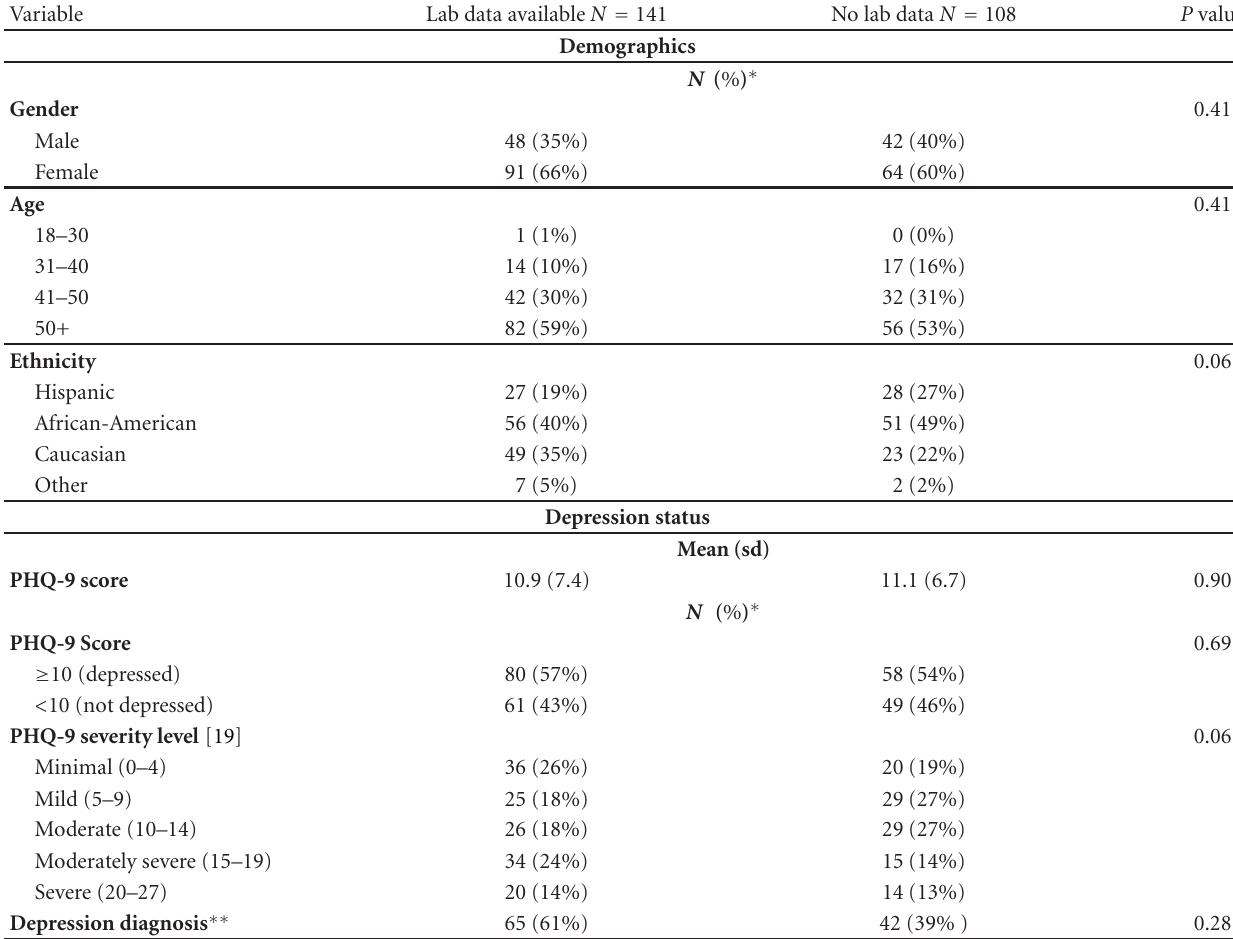
Table 1: Characteristics of the